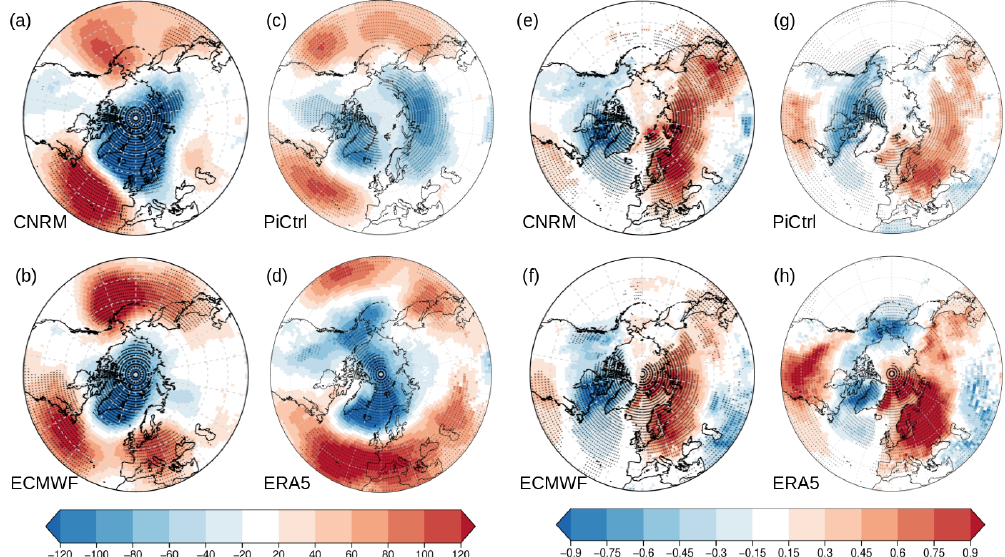
Figure 7. Composite anomaly of week 3 sea-level pressure (in pascals) following NAO+ initial conditions in (a) CNRM forecasts ( n = 870), (b) ECMWF forecasts ( n = 1027), (c) CNRM piControl pseudo-forecasts ( n = 957) and (d) ERA5 reanalysis ( n = 203). (e–h) Like (a)–(d) for 2m temperature (in kelvin) initial conditions. Anomalies statistically significant at the 95% level are stippled.